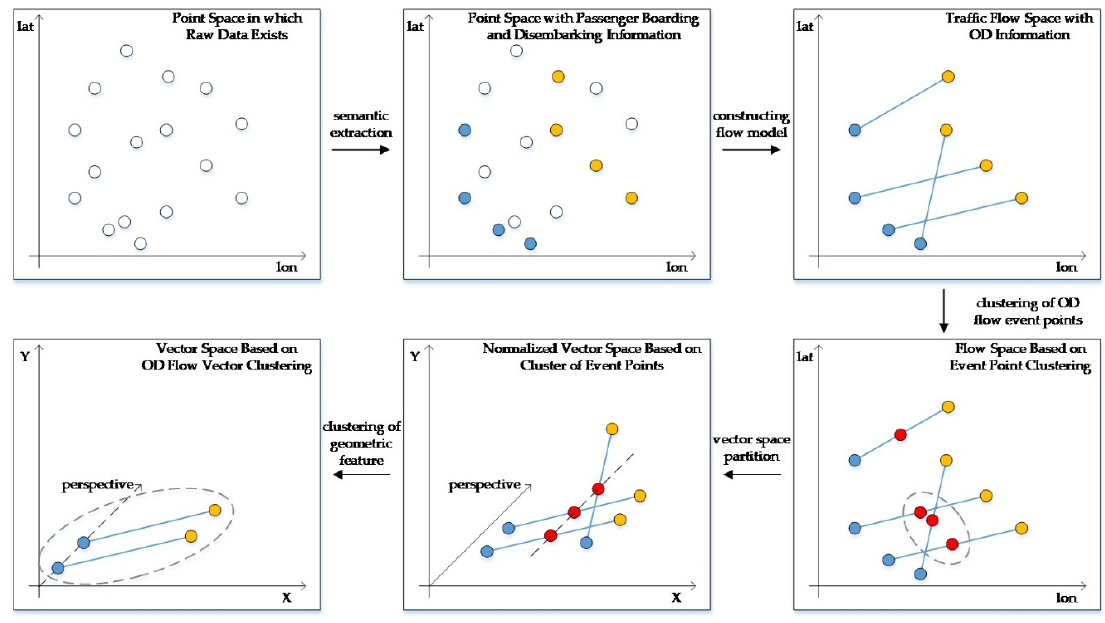
Figure 6. Logic diagram of clustering algorithms.